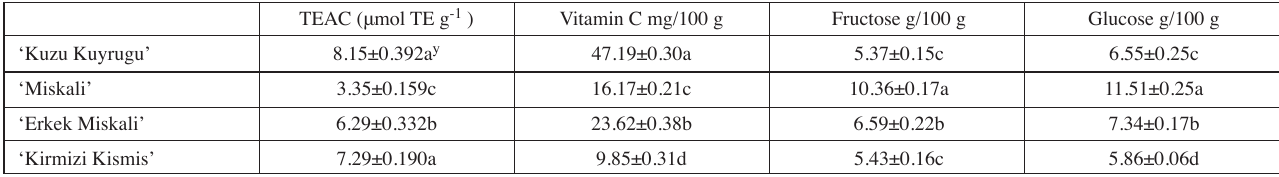
Tab. 2: Content of vitamin C, fructose and glucose and trolox equivalent antioxidant capacity (TEAC) in berries of grape accessions.